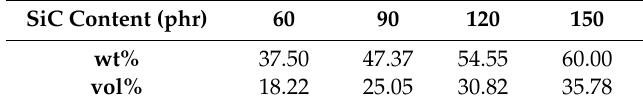
Table 3. The unit conversion of the SiC content in the epoxy resin / SiC